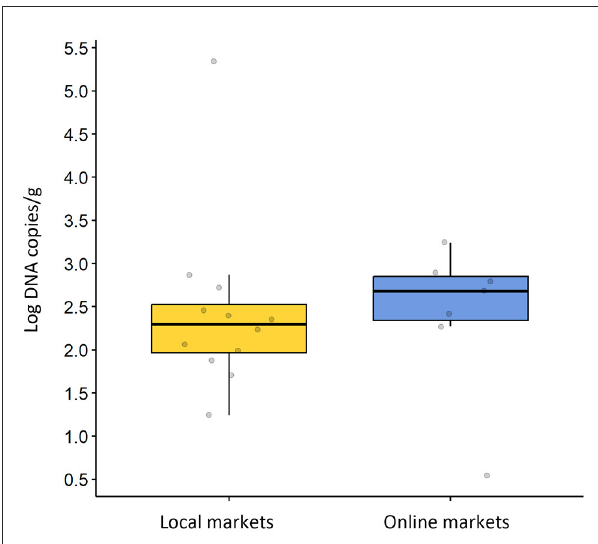
FIGURE1 The detected levels of AdV genome copy number depending on the market